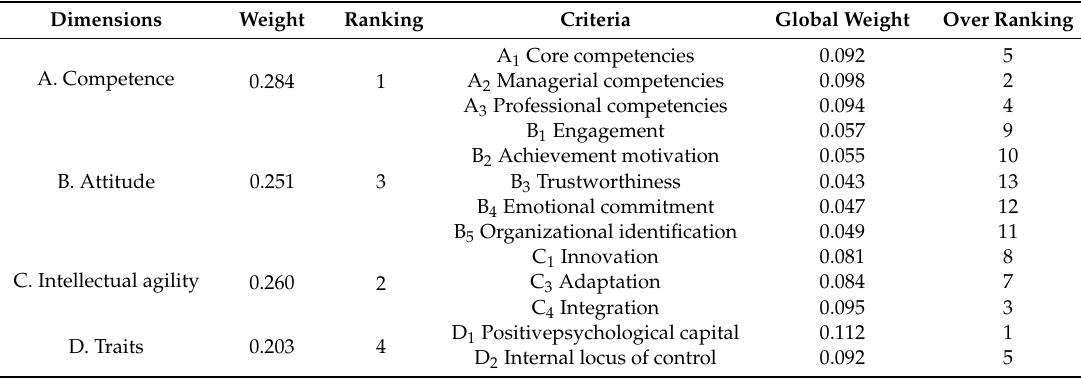
Table 10. DANP weights of dimensions and